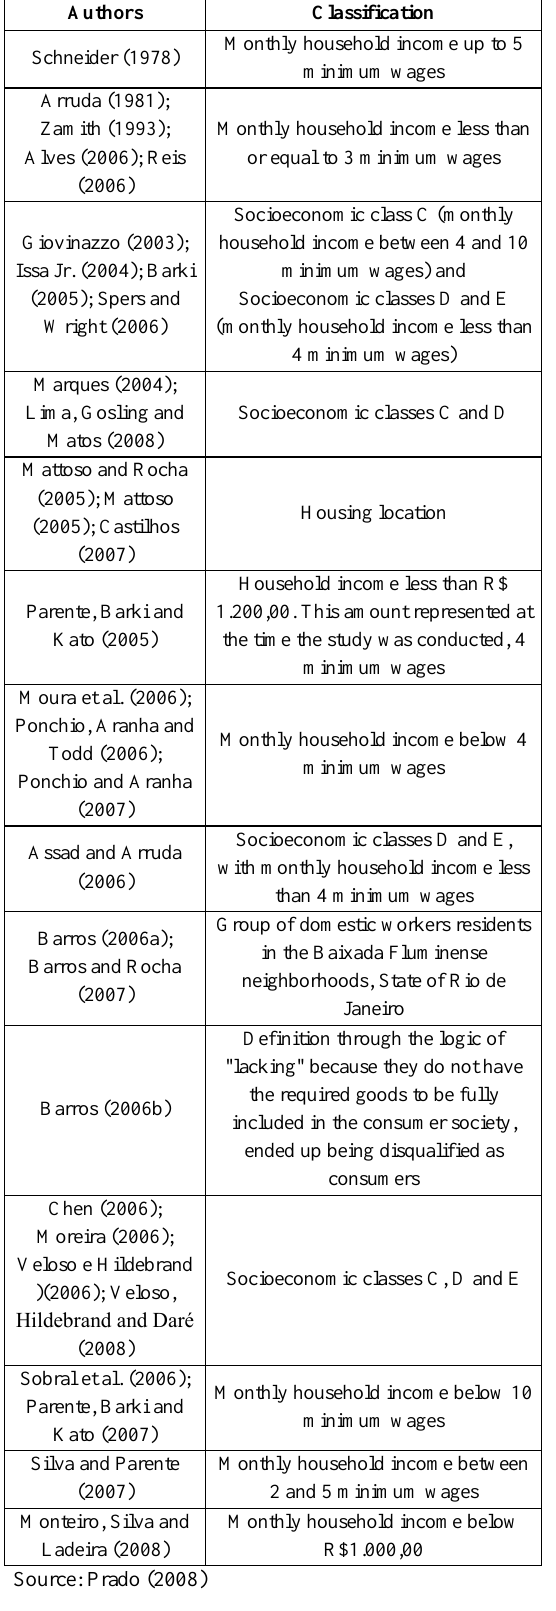
Table 1 – Low income in Brazilian academic papers Authors